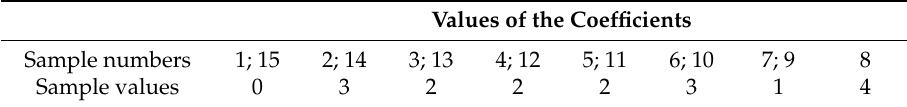
Table 7. Impulse response of the 15th order DF represented in the finite field algebra.